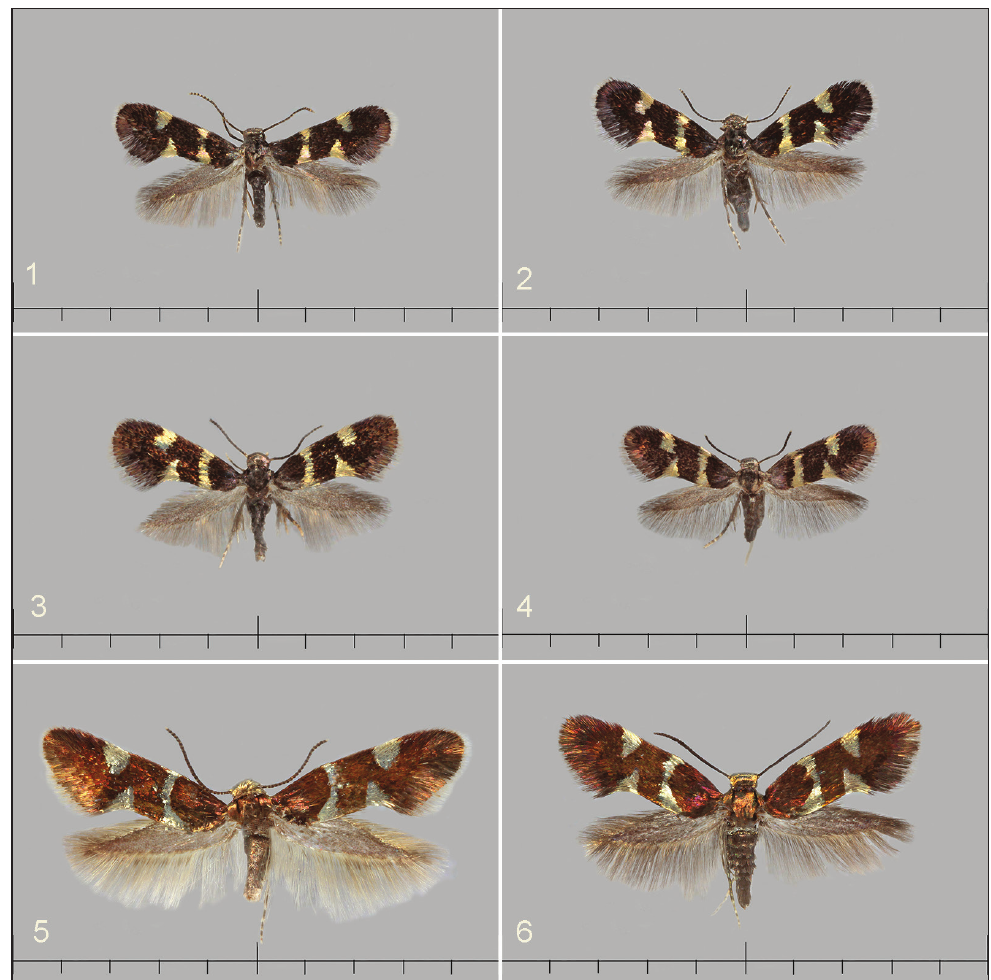
Figures 1–6. Antispila , adult habitus, all from Switzerland . 1 A. petryi , male, Mont Vully, Sugiez, e.l. 08.v.2016 2 A. petryi , female, Mont Vully, Sugiez, e.l. 30.iv.2016 3 A. treitschkiella , male, Gampelen, e.l. 17.iv.2016 4 A. treitschkiella , female, Le Landeron, e.l. 17.iv.2016 5 A. metallella , male, Muntelier, 30.iv.1990 6 A. metal- lella , female, Cudrefin, e.l. 18.iii.2015. All to same scale, scale line 10 mm. Photos: Rudolf Bryner.